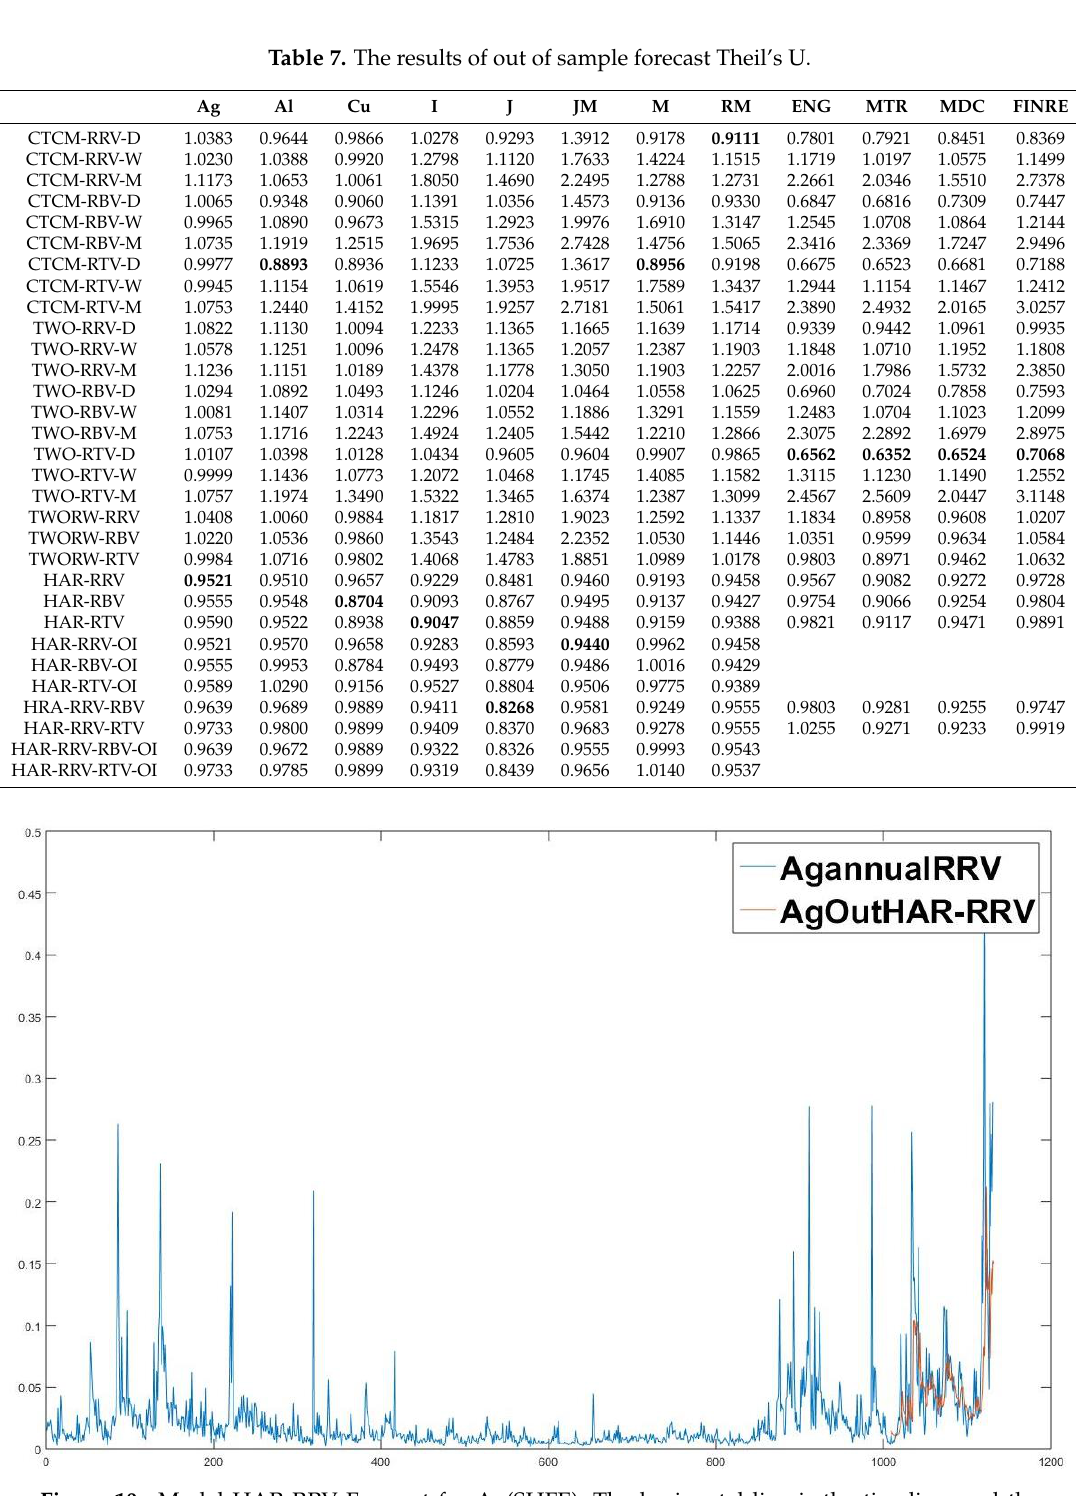
Figure 10. Model HAR-RRV Forecast for Ag(SHFE). The horizontal line is the timeline, and the perpendicular line is the volatility estimator. The forecasted period is the last 124 days. The actual values are represented by the blue line, while the forecasted values are represented by the orange line. The forecasted values capture the characteristics of to the actual values, but are not close to the actual values when there is a sharp